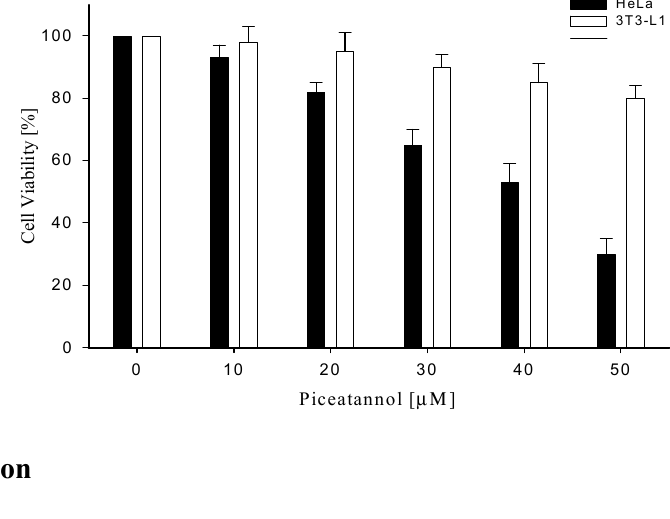
Figure 5. Anti-cancer activity using biotransformed piceatannol. 3T3-L1 was used as a normal animal cell